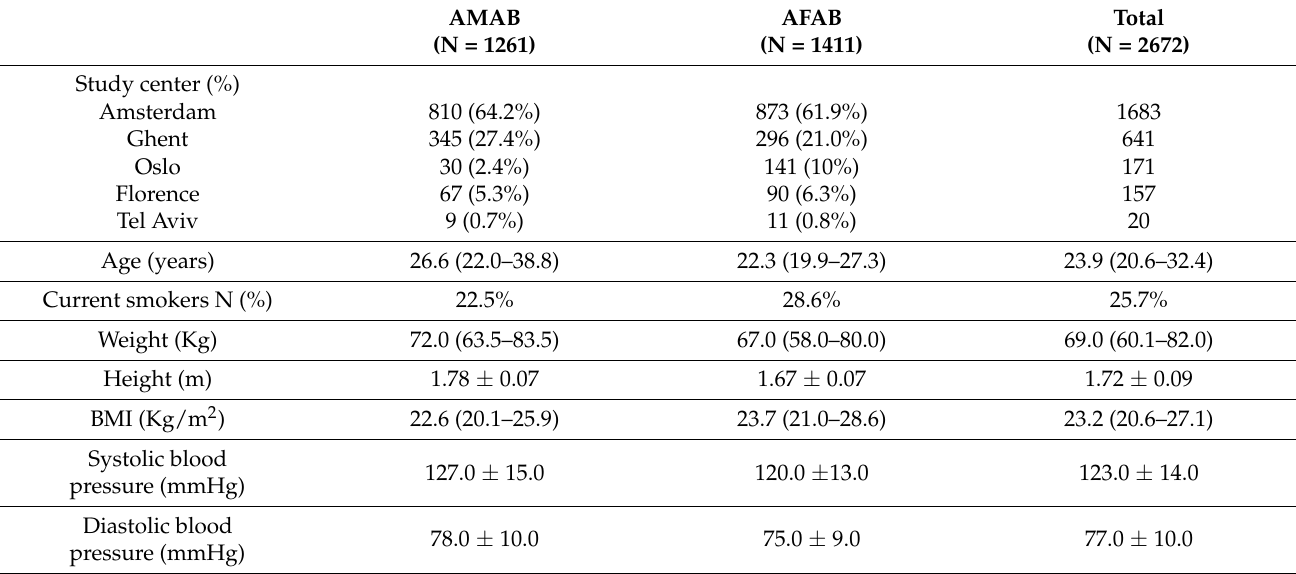
Table 1. Baseline characteristics of the study